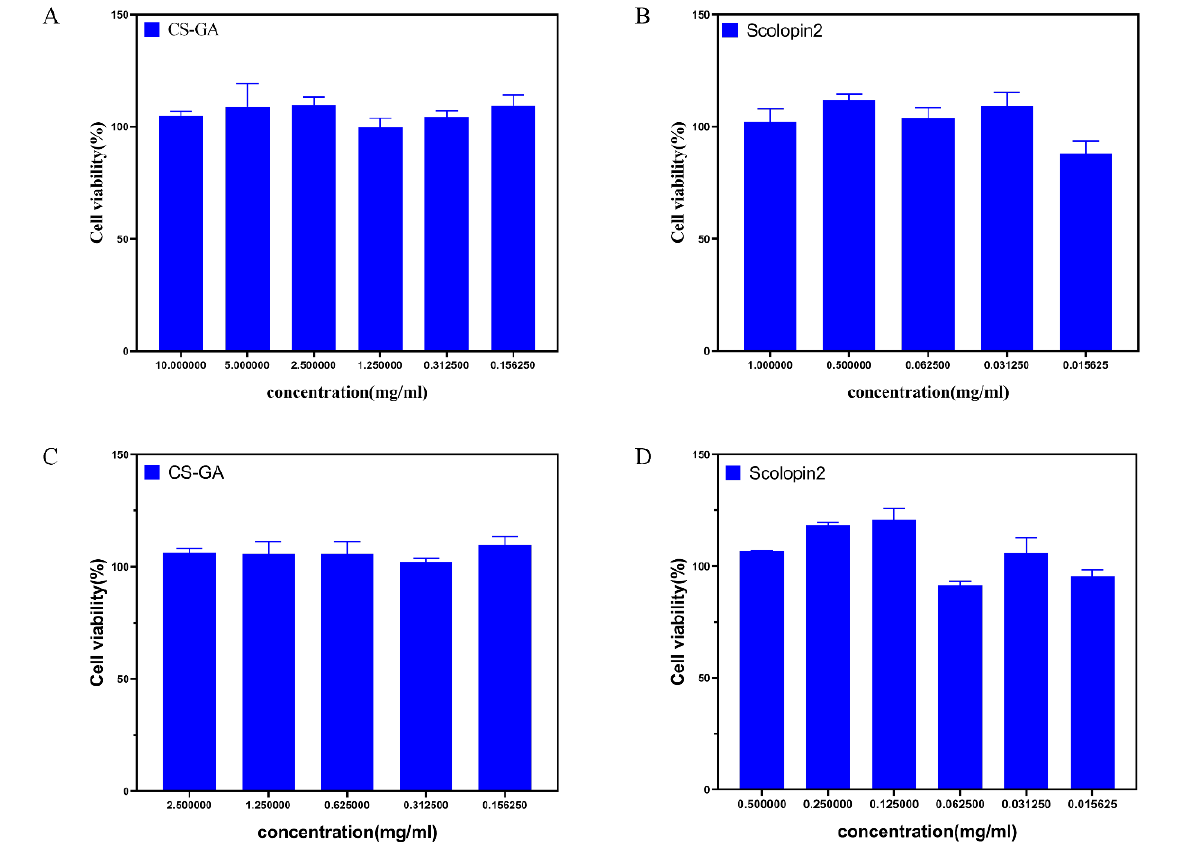
Figure 8. The NIH3T3 cell viability with ( A ) CS-GA and ( B ) scolopin2. The Caco-2 cell viability with ( C ) CS-GA and ( D ) scolopin2.